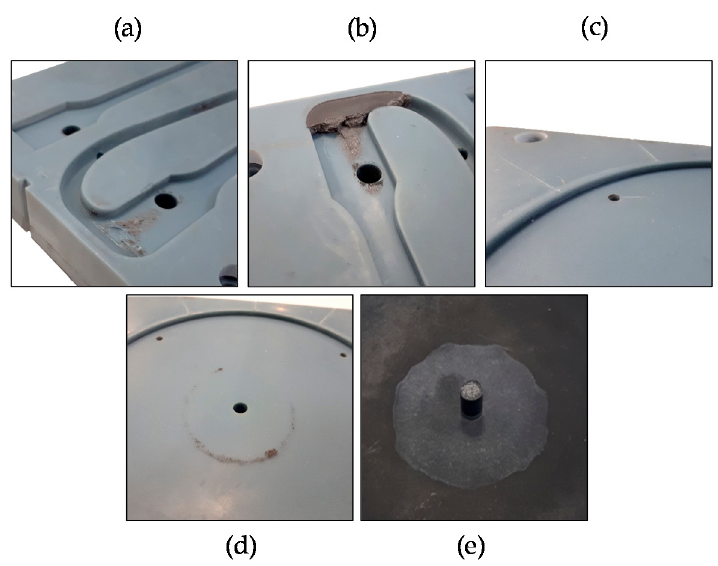
Figure 13. Failure modes and tool deterioration during specimen manufacturing: demolishing of mold at areas with strong staircase effect ( a ); clogging of channels at fiber contents of 60 wt.% ( b ); abrasion of mold material at the edges resulting in flash on parts ( c ); penetration of mold through fibers and PP at regions of high impact ( d ); contamination of parts through scraped mold material ( e ).